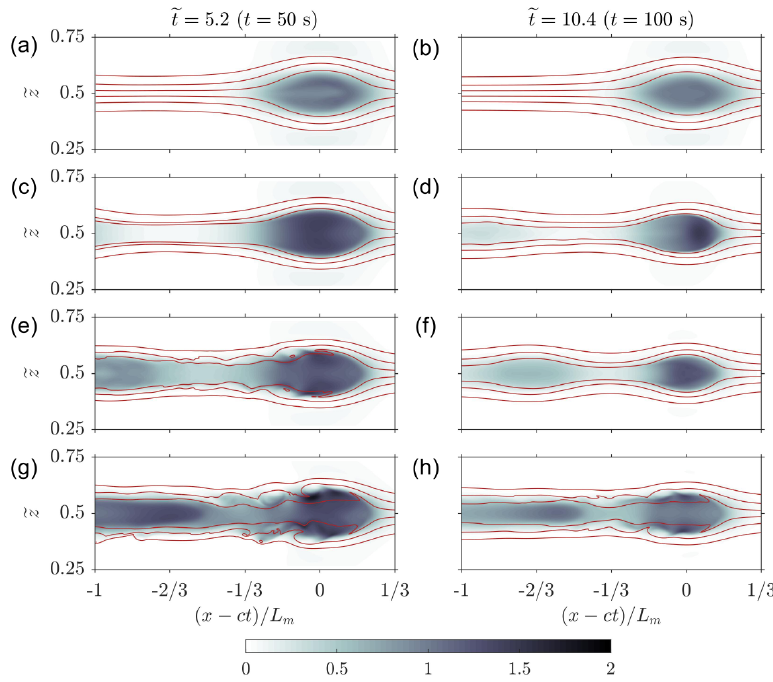
Figure 11. Kinetic energy density at e y = 0 for f/f 0 = (a, b) 0, (c, d) 1 / 2, and (e, f) 1. Red contours are the same as in Fig. 9. All cases have Sc =